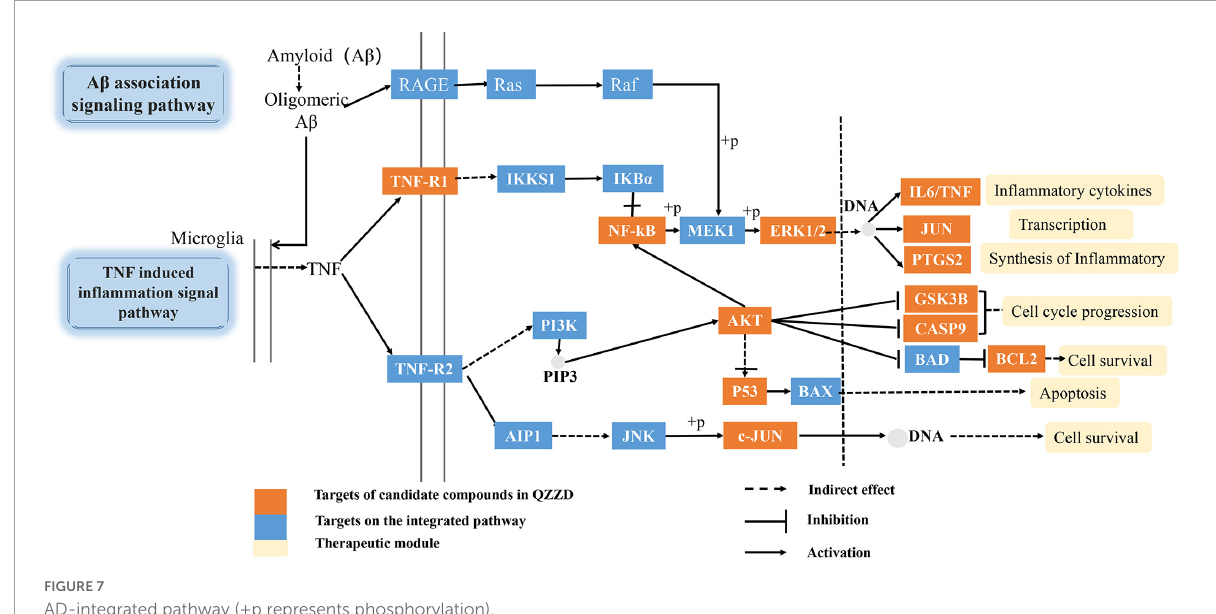
FIGURE7 AD-integrated pathway (+p represents phosphorylation).